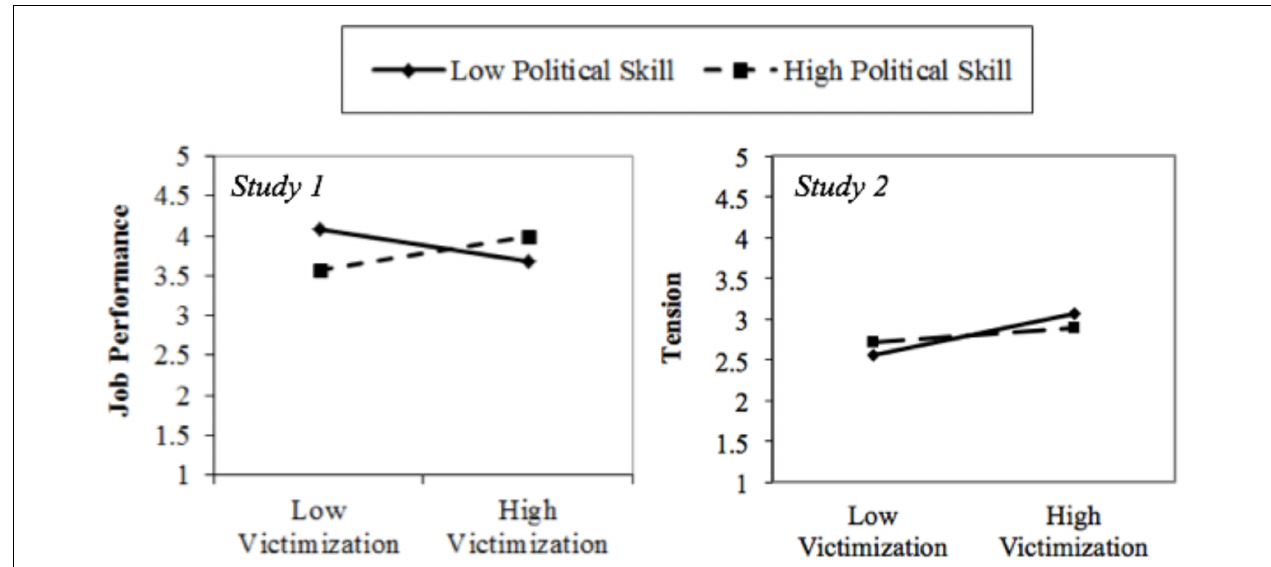
FIGURE 2 | Outcomes on the interaction between perceptions of a victimizing environment and political skill for Studies 1 and